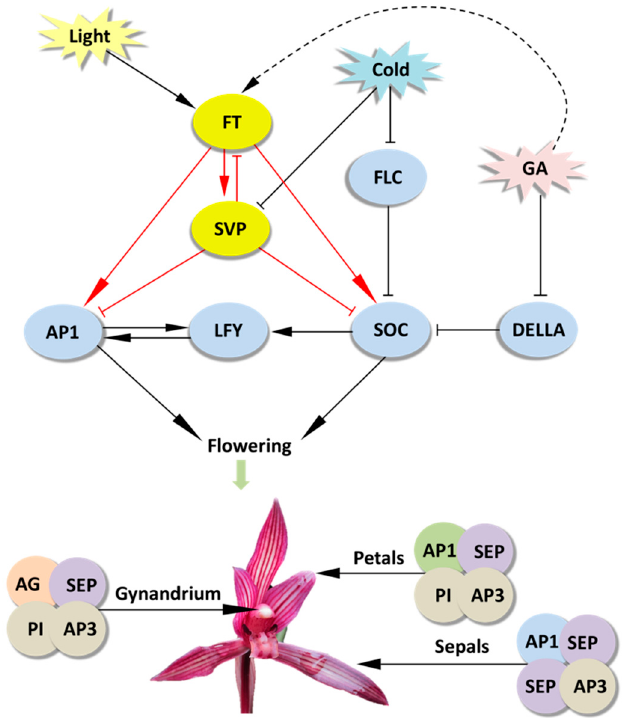
Figure 6. Conserved putative genetic regulatory networks of flowering in plants. Genes are represented by ovals. Lines with an arrow represent promotion, and those with a perpendicular bar represent repression. Red lines indicate regulation analyzed in this study.